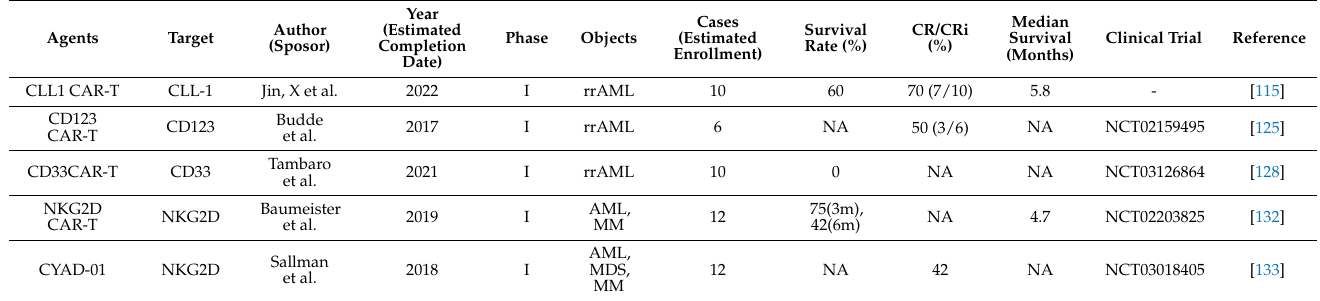
Table 3. Summary of recent clinical trials of CAR-T therapy in AML and/or